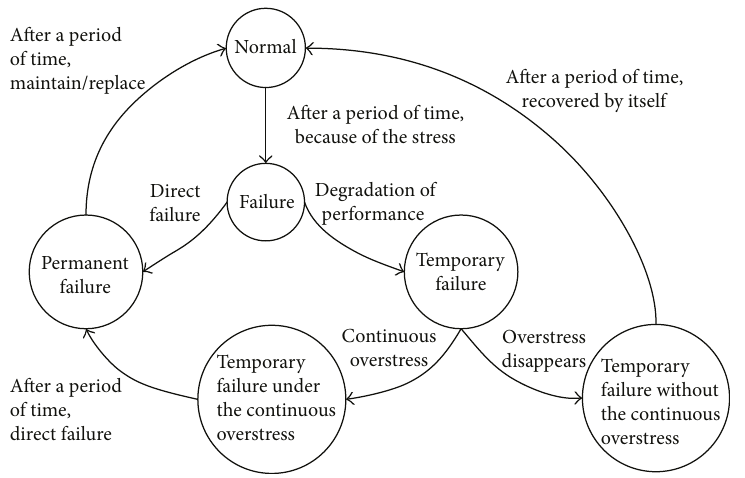
Figure 1: Transition behavior of IMA hardware error